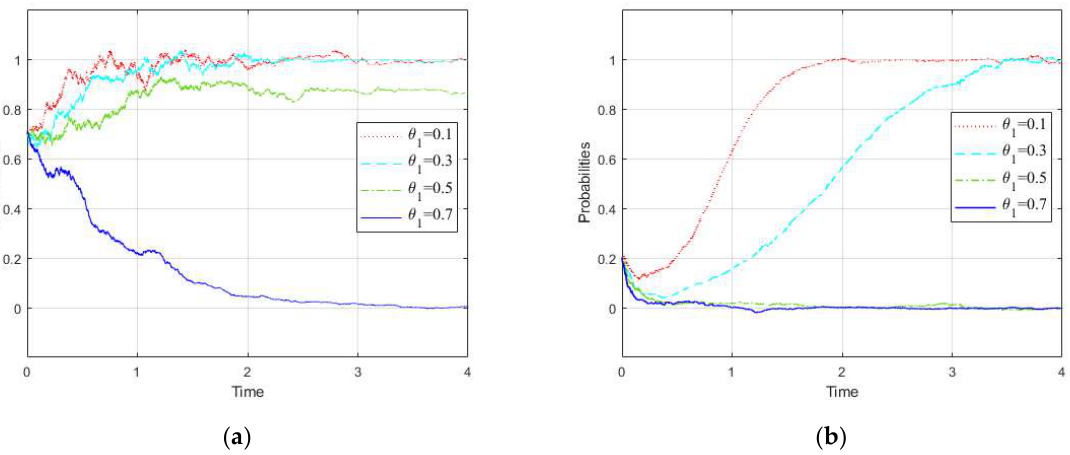
Figure 4. Influence rule of changes of θ 1 on Branch Government 2: ( a ) influence rule of changes of θ 1 on Branch Government 2 when x (0) = 0.7, y (0) = 0.7, z (0) = 0.7, and ( b ) influence rule of changes of θ 1 on Branch Government 2 when x (0) = 0.2, y (0) = 0.2, z (0) = 0.2. (3) Influence rule of change of θ 1 on the mainstream government